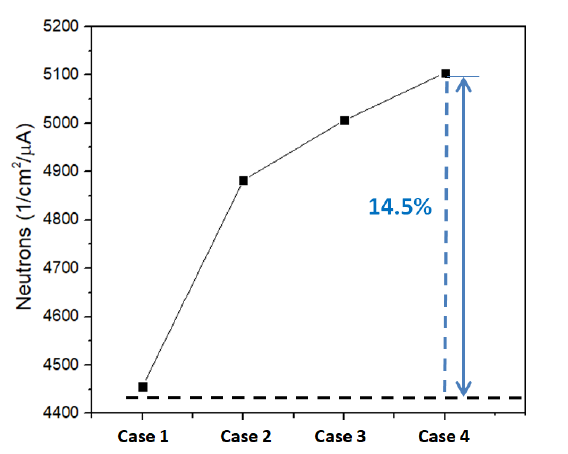
Fig. 7. Cold neutron intensity as a function of the graphite reflector